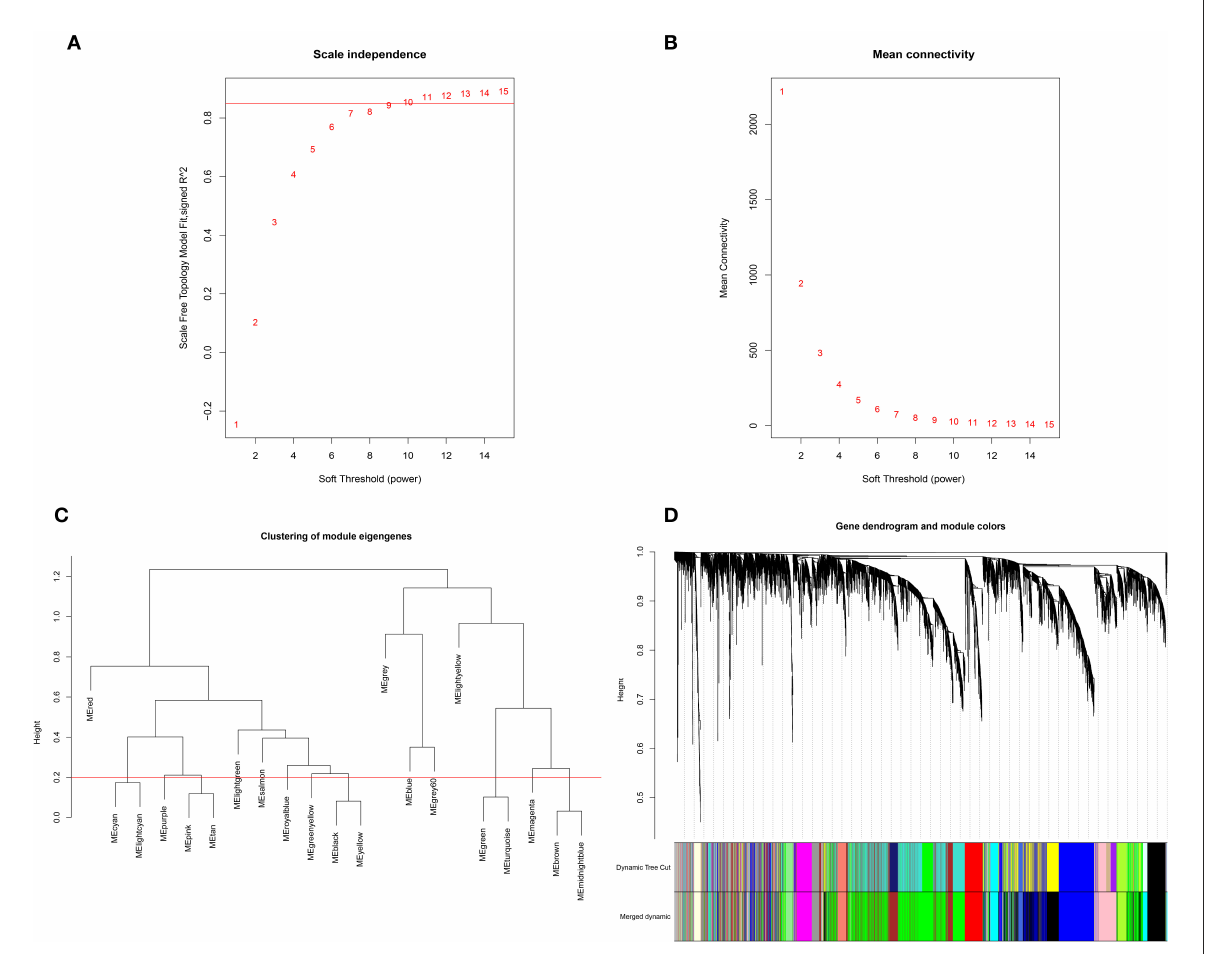
FIGURE1 Identify soft thresholds and filter modules. (A) Scale-free topology fit index. (B) Mean connectivity of different soft-thresholding power. (C) The cluster dendrogram of gene modules eigengenes. (D) The gene clustering dendrogram.